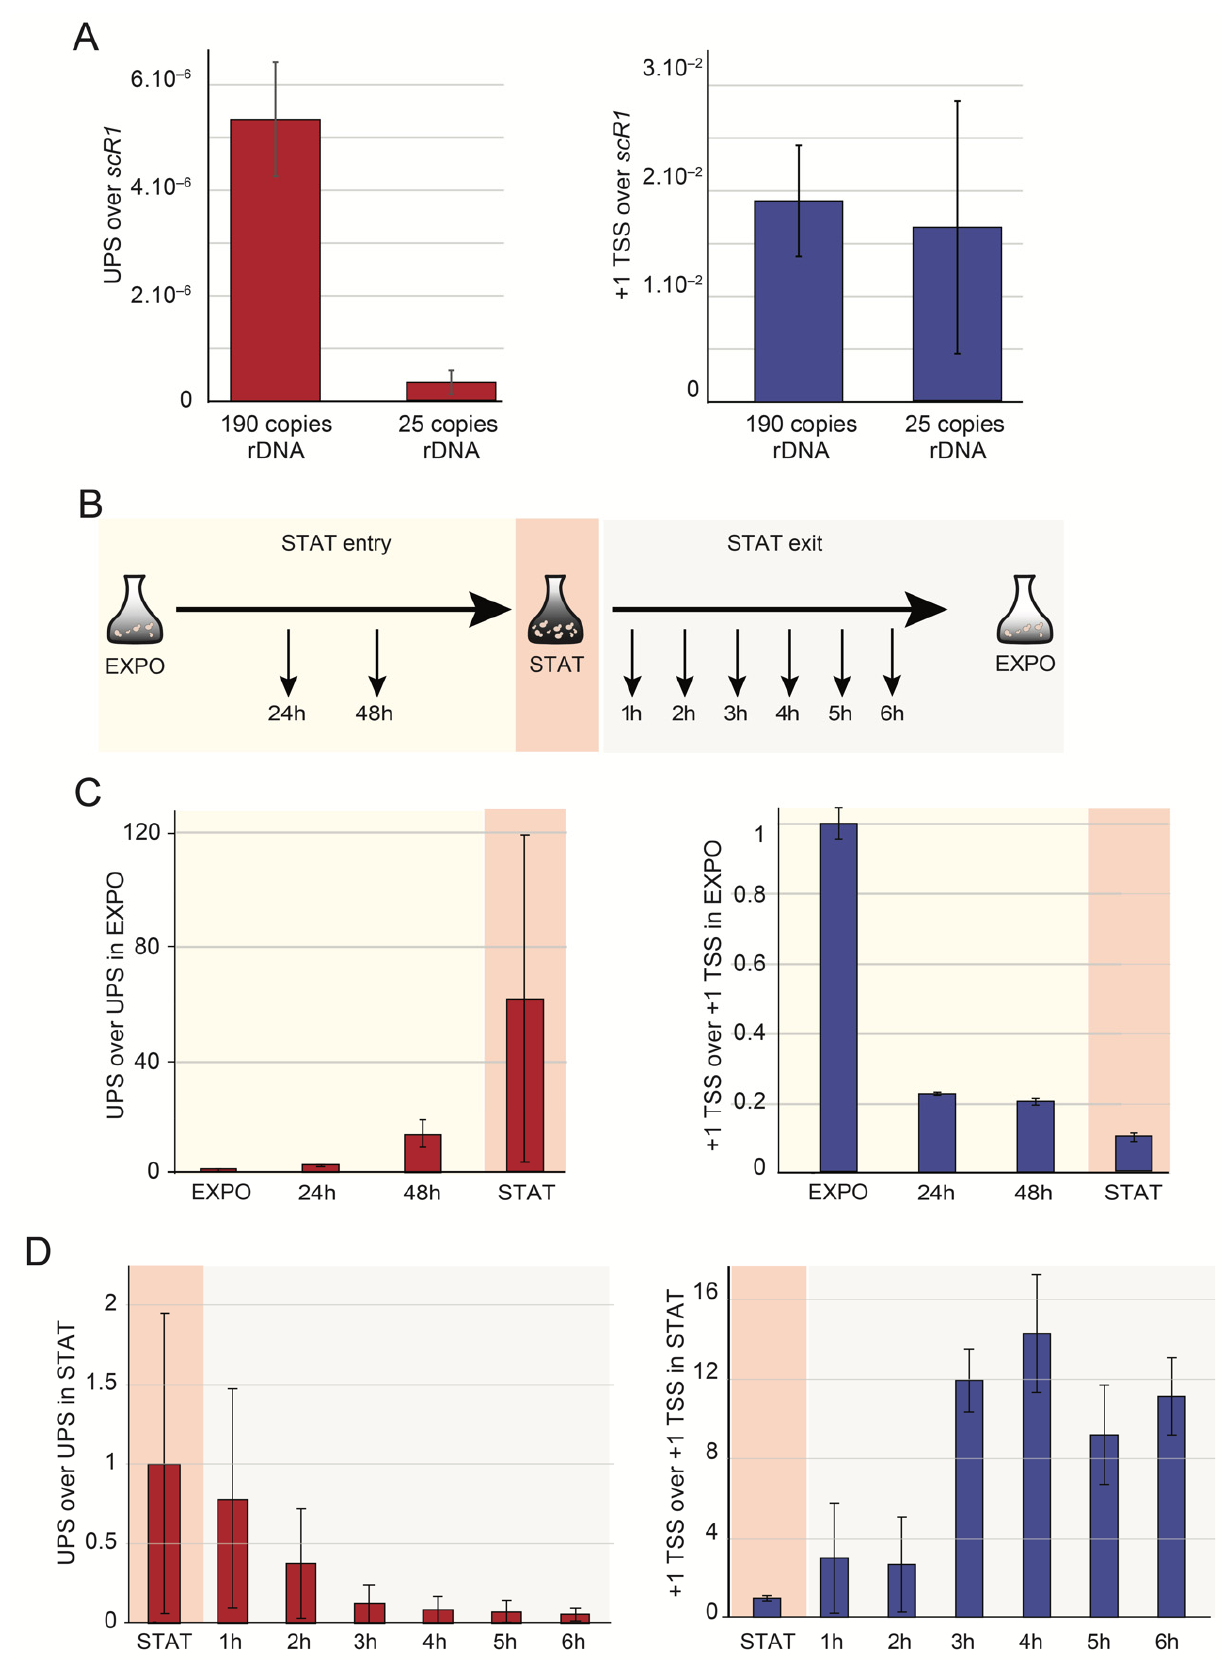
Figure 5. UPS are produced from closed rDNA copies, accumulated in quiescent cells, and anti-correlated with +1 TSS rRNA. ( A ) UPS levels were higher in 190-copy rDNA strains when compared to those with 25 rDNA copies. Strains bear- ing 190 or 25 rDNA copies were grown to the exponential phase (ON) at 30 °C in YPD media. RNA was extracted, reverse transcribed with RT and sCR1-R primers, and subsequently quantified as in Figure 1C. Both UPS (red) and +1 TSS (blue) are shown. ( B ) Schematic representation of time-course experiment. Cells were grown overnight to the exponential phase, samples were collected (EXPO) then incubated over the following 24 and 48 h when the post-diauxic samples were col- lected (STAT entry). Afterwards, cultures were cultivated for additional 9 days (11 days of culture in total, STAT) and collected. Stationary cells were then resuspended in fresh YPD medium and cultivated for 6 h (STAT exit). Each hour, cells